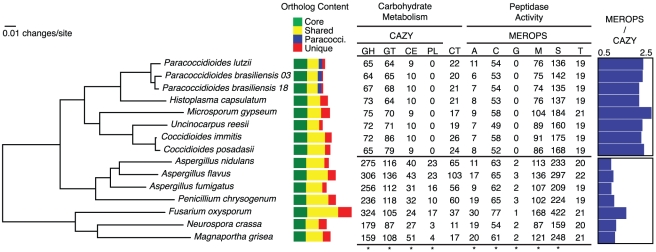
Phylogeny of the dimorphic fungi, shared gene content, and clade-specific carbohydrate and protein metabolism.The phylogeny was inferred by maximum likelihood using RAxML [103] from a concatenated alignment of 309 single copy orthologs shared across all taxa. All nodes on the phylogeny were supported with bootstrap values of 100%. Colored bars indicate orthologs shared across all taxa (green), orthologs shared across some taxa (yellow), Paracoccidioides-specific (blue) and species-specific genes (red). Numbers of genes for each taxon involved in carbohydrate metabolism and peptidase activity are shown. Categories with asterisks at the bottom of the column are significantly enriched in the non-dimorphic fungi relative to the dimorphic fungi. Carbohydrate active enzyme (CAZY) categories include glycoside hydrolases (GH), glycosyltransferases (GL), carbohydrate esterases (CE), and pectate lysases (PL). Numbers of carbohydrate transporters (CT) are also listed. Peptidase (MEROPS) categories include aspartic (A), cysteine (C), glutamic (G), metallo (M), serine (S) and threonine (T). The ratio of MEROPS genes to CAZY genes for each genome is shown on the right.